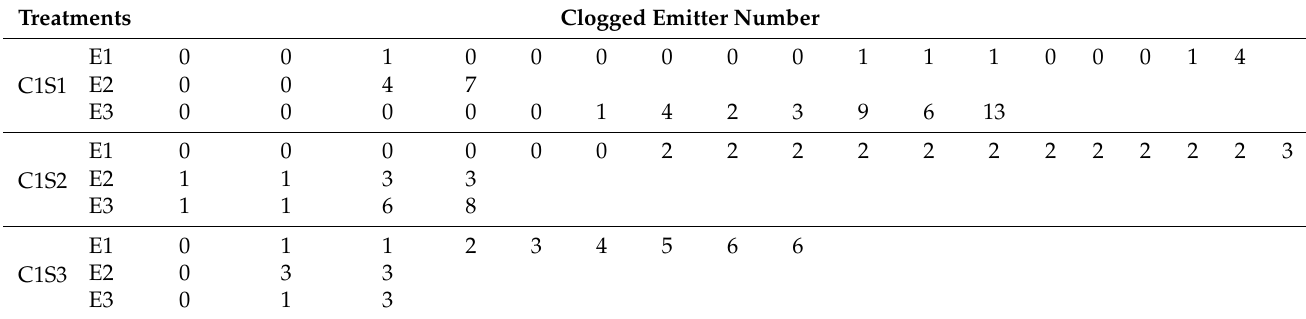
Table 4. Number of blockages in each